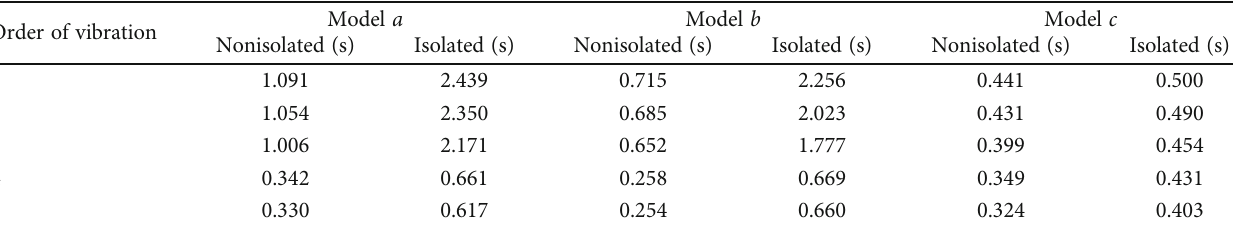
Table 3: Vibration period of di ff erent staggered